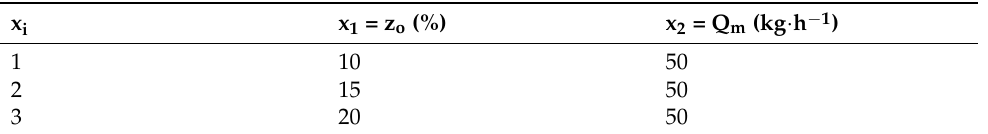
Table 1. Research plan matrix for the pelletization process of sawdust with the addition of post- flotation sewage sludge (z o